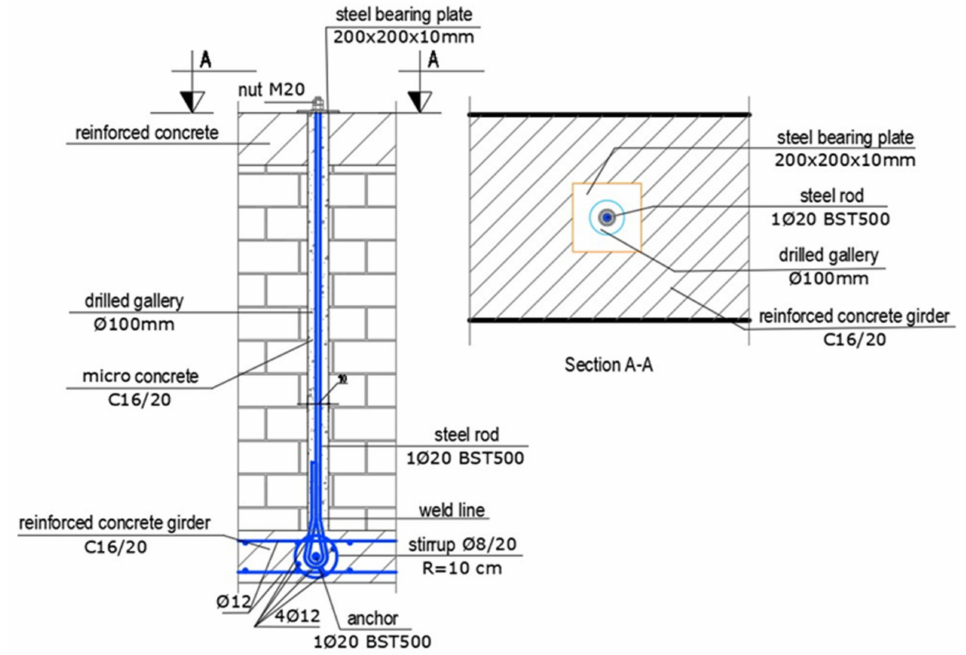
Figure 15. Drilled galleries and steel road